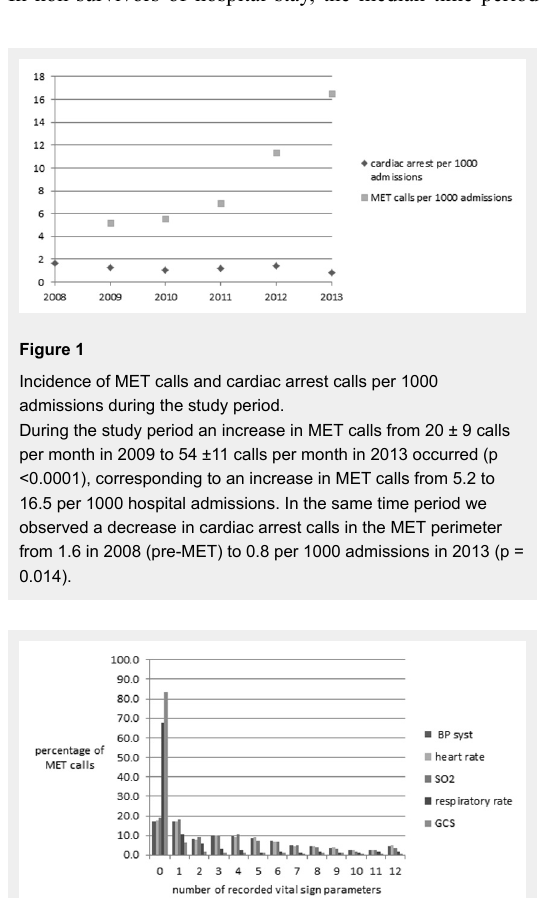
Number of vital sign parameters recorded during the 24 hours before MET